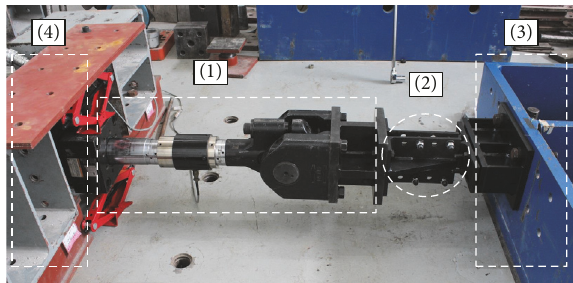
Figure 4: Test configuration; (1) hydraulic actuator, (2) the MHD without the LRB, and (3) and (4) reaction frames.